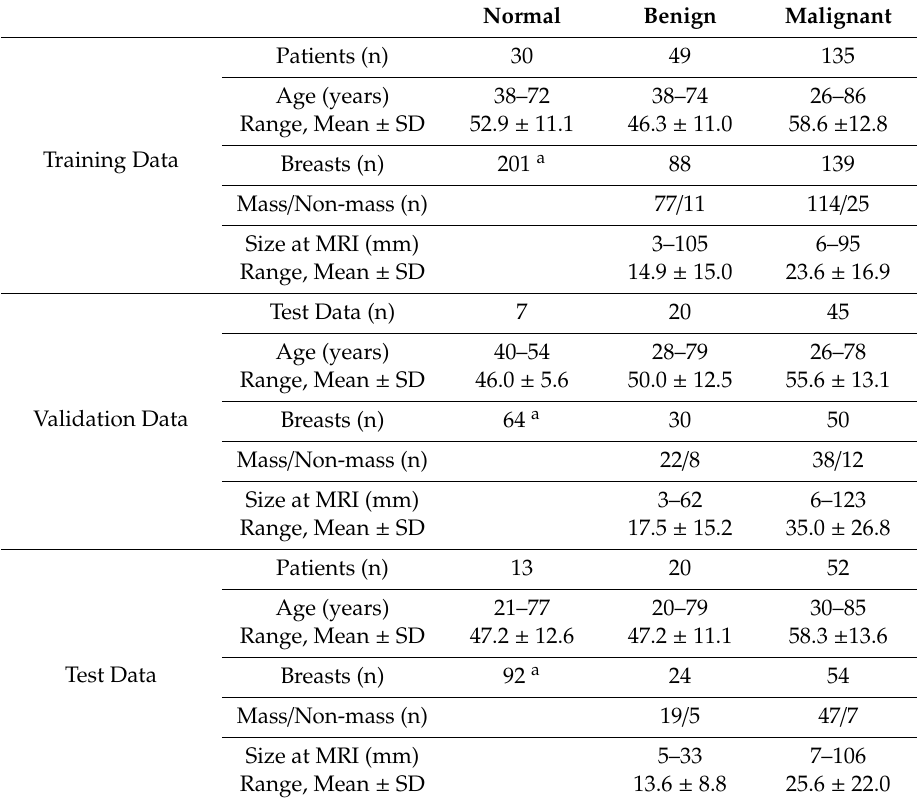
Table 2. Characteristics of patients and images.